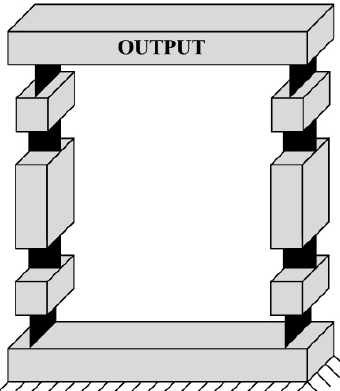
Figure 12. Principle of a possible design of a passive brick per- forming two rotations and two translations. This mechanism is of- ten referred to as “space